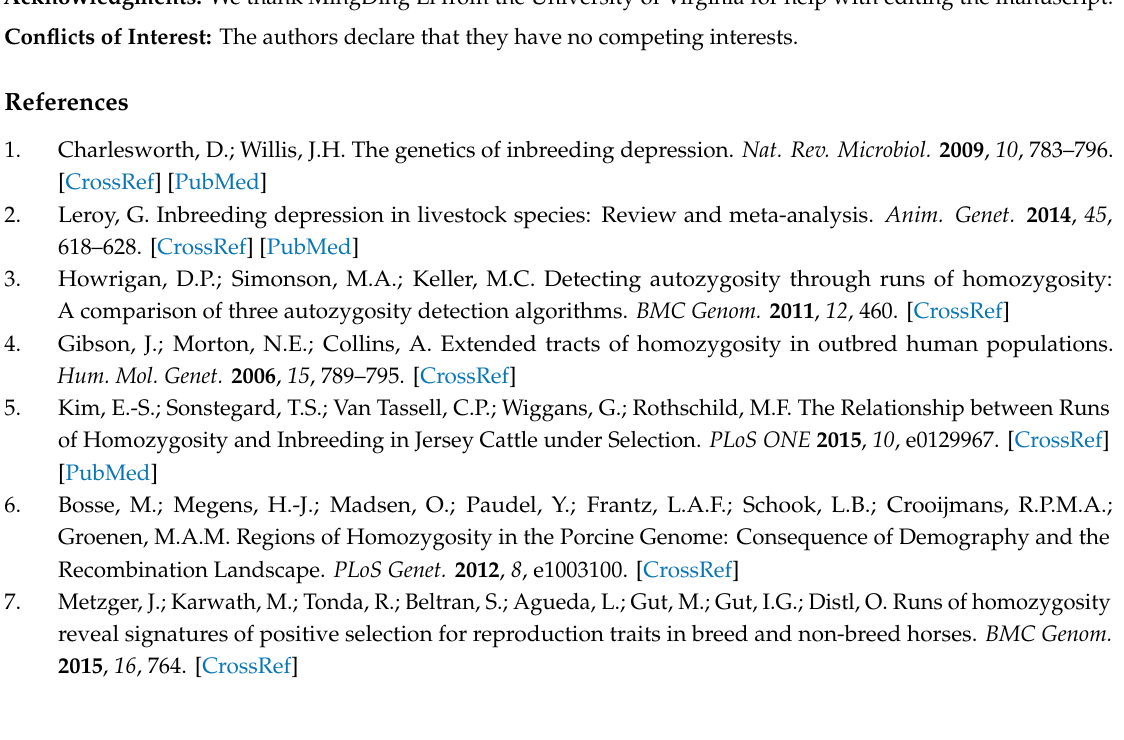
Table S1: The estimated average observed heterozygosity ( He ), Table S2A: The inbreeding coe ffi cient of the inbreeding and non-inbreeding pigs, Table S2B: Correlation inbreeding coe ffi cient F and F(ROH) across generations in the inbreeding and non-inbreeding pigs, Table S2C: Student t-tests between inbreeding coe ffi cients of the inbreeding and non-inbreeding pigs, Table S3: ROH region at inbred and non-inbred strain for each generation. Author Contributions: Experimental design: L.W., L.X., and S.F. Sample collection and genotyping: Y.M., K.L., J.H., T.W., L.L., Q.G., Y.X., G.H., S.Y., and X.H. Result interpretation: L.W., L.X., G.E.L., and S.F. Manuscript preparation: L.W., L.X., G.E.L., and S.F. All authors read and approved the final